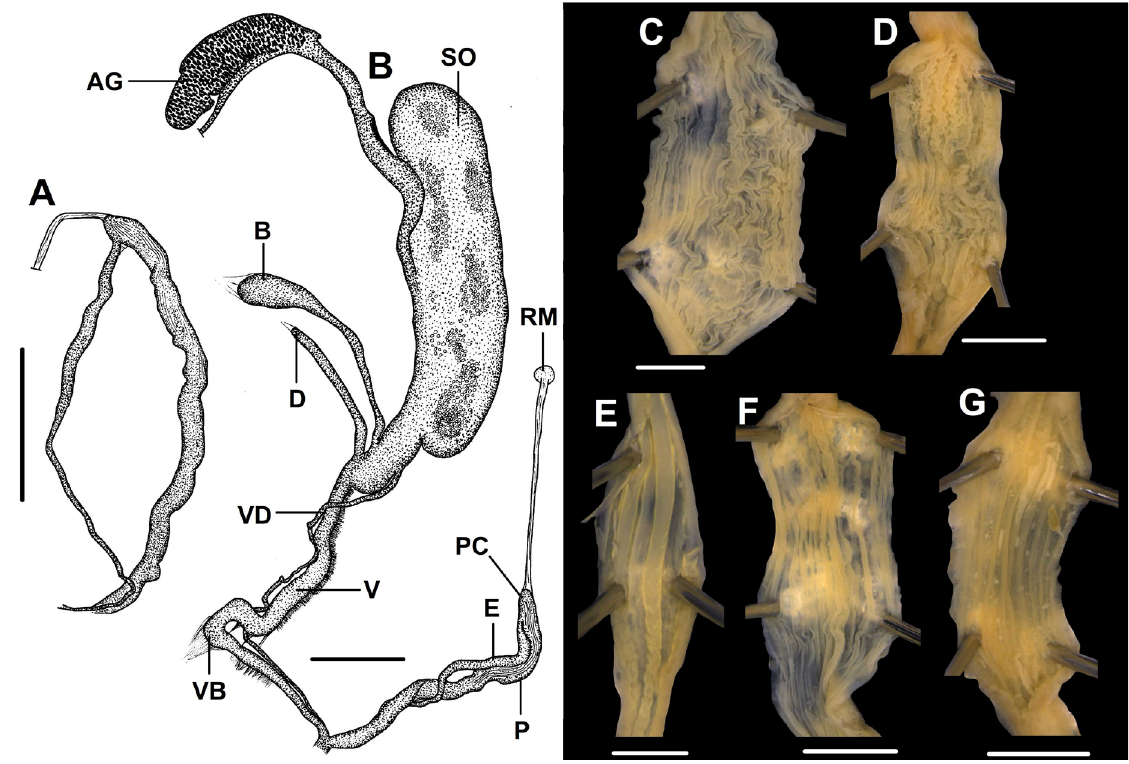
Fig. 13. Genitalia of Chersaecia reversalis sp. nov. (UF 347047). A . Male genitalia (penis, epiphallus, vas deferens). B . Whole genitalia. C–G . Inner structure of genital organs (C = proximal part of penis; D = distal part of penis; E = epiphallus; F = vagina; G = diverticulum). Scale bars: A–B = 5 mm; C–G = 0.5 mm. For abbreviations see Fig. 2. All photos: B.